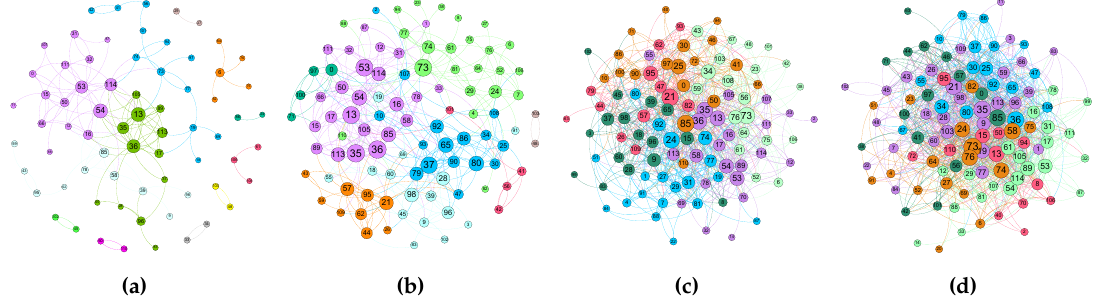
Figure 5. Contact graph for different time intervals of the trace: ( a ) 3 h; ( b ) 6 h; ( c ) 12 h and ( d ) 24 h.